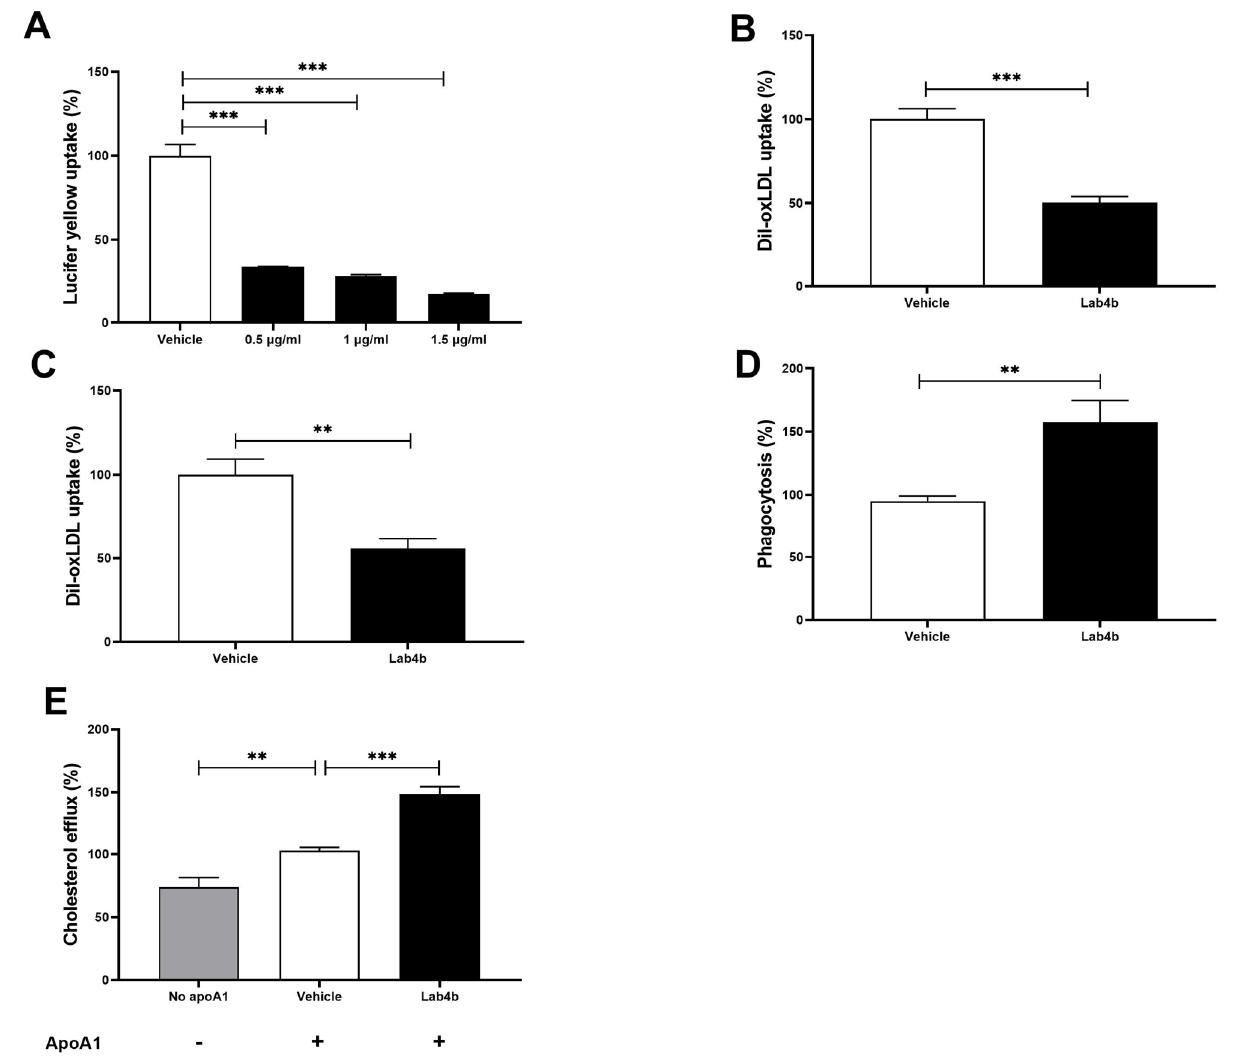
Figure 3. Lab4b CM modulates several processes associated with foam cell formation in human macrophages. THP-1 macrophages ( A , B , D ), HMDM ( C ) or THP-1 macrophage-derived foam cells ( E ) were used to determine macropinocytosis ( A ), Dil-oxLDL uptake ( B , C ), phagocytosis ( D ), and cholesterol efflux ( E ). Macropinocysosis was carried out using three different concentrations of Lab4b CM (0.5 μ g/mL, 1 μ g/mL, and 1.5 μ g/mL), whereas, 1.5 μ g/mL was used for all the other assays. The values in cells treated with vehicle alone ( A – D ) or vehicle and apolipoprotein (apo) A1 (10 μ g/mL; ( E ) were arbitrarily assigned as 100%. Data are mean ± SEM from three independent experiments, and statistical analysis was carried out using one-way ANOVA with Dunnett ( A ; log transformed data) or Bonferroni ( E ) post-hoc test, an unpaired Student’s t-test ( B , C ) or unpaired Welch’s t-test ( D ) (**, p ≤ 0.01; ***, p ≤ 0.001).